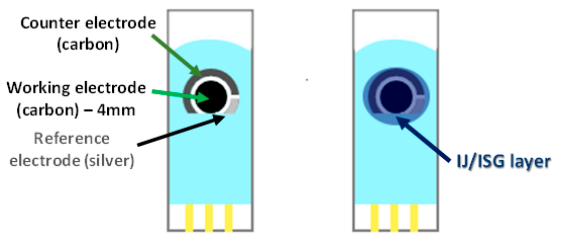
Figure 1. R epresentation of a clean SPE ( left ), and an SPE covered with a layer of IJ or ISG on top ( right